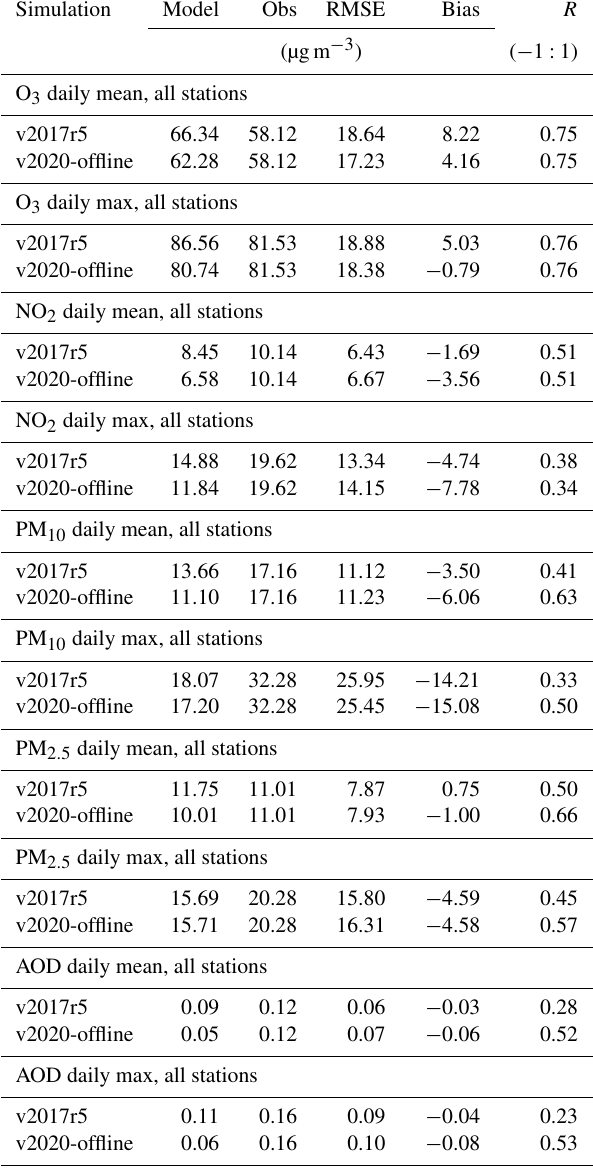
Table 2. Main results for the v2017r5 and v2020r1 versions of the CHIMERE model. Scores are calculated by comparison between surface observations for several stations in Europe and the corre- sponding model daily mean and maximum value. Statistical scores are presented for O 3 , NO 2 , PM 10 , PM 2 . 5 , and